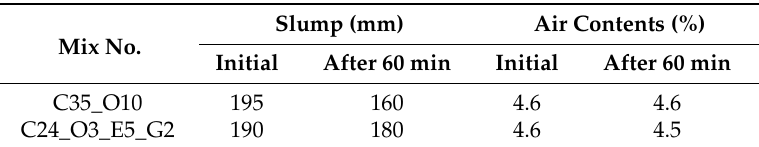
Table 6. Fresh properties of